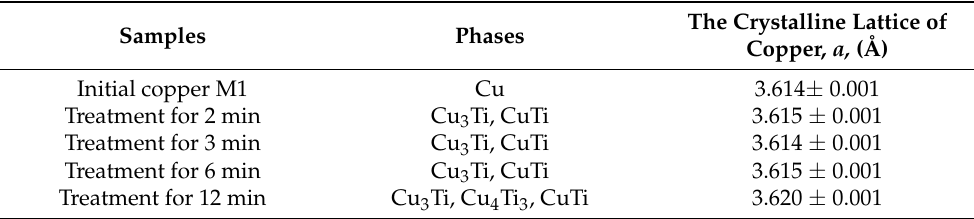
Table 2. Phase composition and parameter of the crystalline lattice of the copper treated under titanium ions.